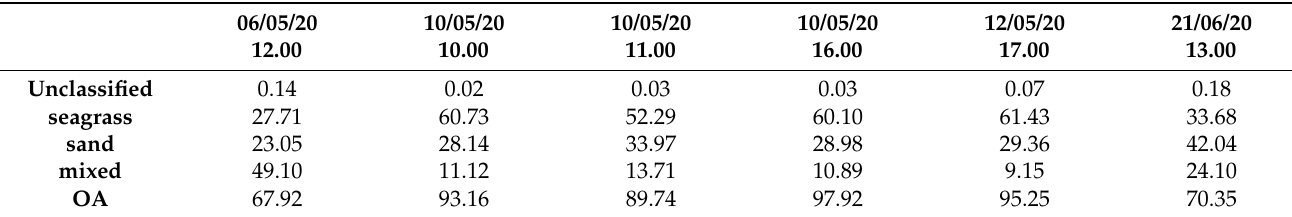
Table A1. Maximum Likelihood (ML) classification statistics of the coverage percentages, (Percentage = (Value⁄Total Value) × 100). On 06/05/20, sunglint areas and big parts of seagrass have been classified as mixed substrate, increasing greatly the coverage percentage of the class to 34.72%. In the 10/05 classified image, there are small differences in class coverages, with the biggest differences in the mixed substrate class which is increased at 11.00 due to sunglint presence. The 12/05/20 classified image has the closest coverage percentages to the reference data, with small differences due to the non-distinction of seagrass parts with the mixed substrate. On 21/06/20 the percentages show that almost 20% of seagrass has been classified as sand and mixed substrate. The overall accuracies vary from 67.92 to 97.92%.